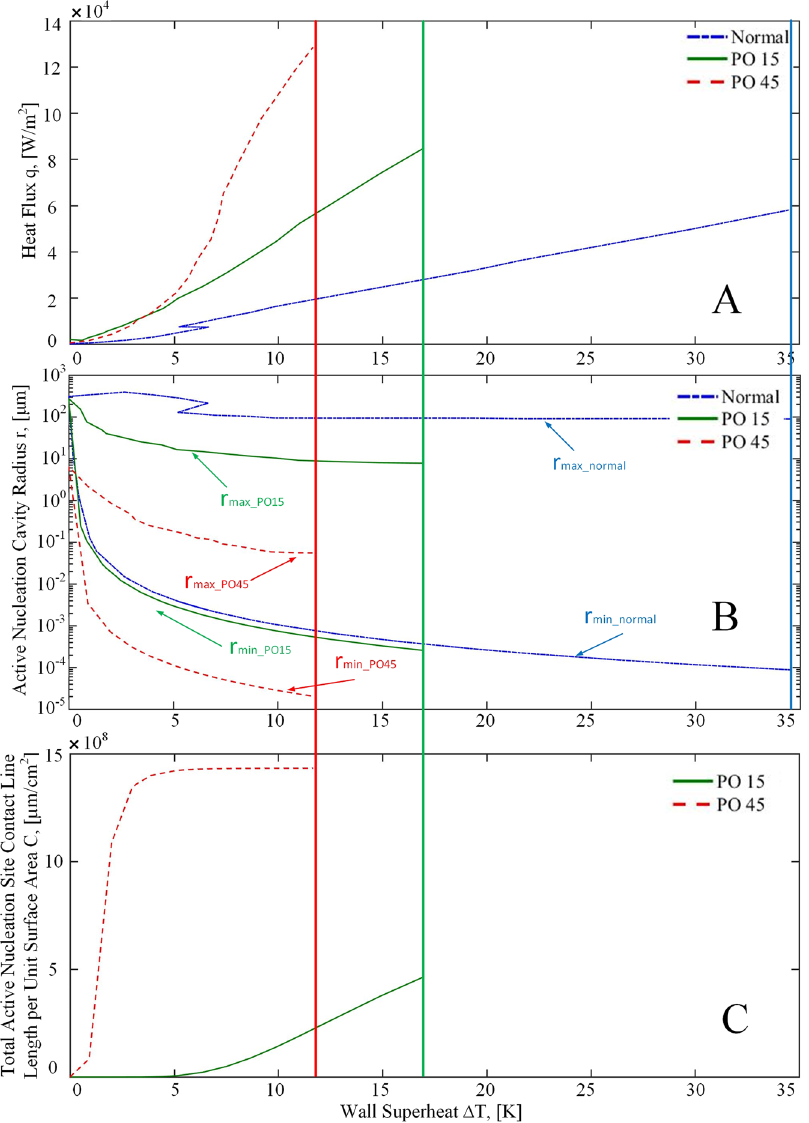
Figure 9. Active nucleation cavity radii range and total active nucleation site contact line lengths based on the heated boiling curve. ( A ) Boiling curve in the nucleate boiling regime. ( B ) Active nucleation site radius range ( C ) total circumference length of active nucleation sites per unit surface